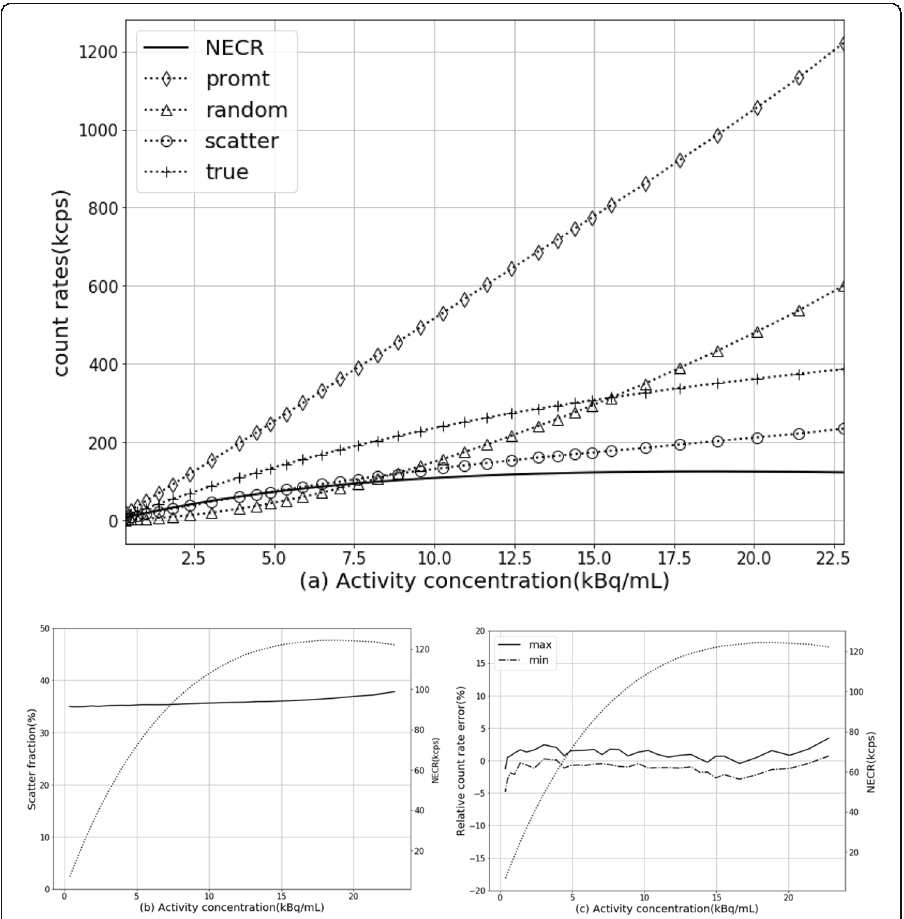
Fig. 2 uMI550 count-rate performance. a The measured count-rate curves of prompt, delayed, scatter, true, and NEC rates. b Scatter fraction curve (solid line) in dependency on activity concentration. c The maximum and minimum relative count-rate error curves for difference activity radio concentration. b , c also plotted NECR curve (dotted line) by using double Y axes